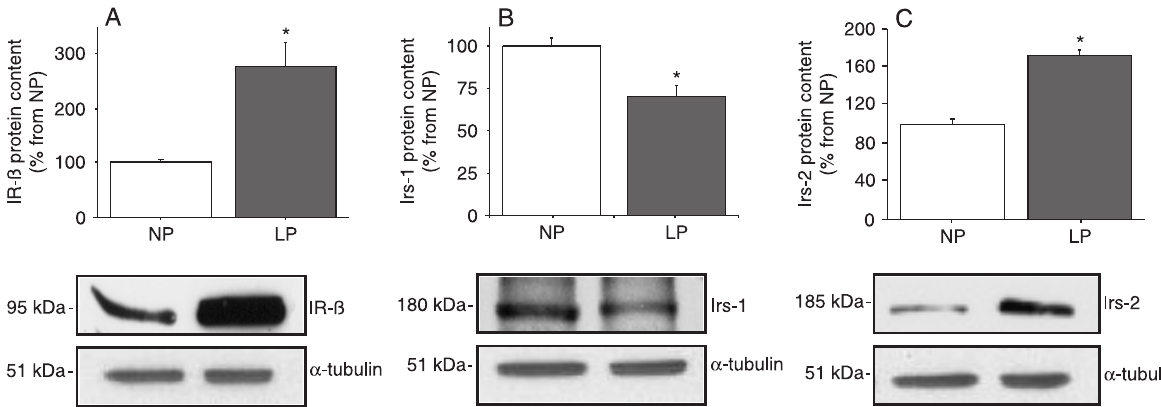
Figure 2. Protein content of A , insulin receptor β (IR-β); B , insulin receptor substrate-1 (Irs-1), and C , insulin receptor substrate-2 (Irs-2) in pancreatic islets from rats receiving a normal-protein diet (NP) and a low-protein diet (LP). A representative control blot for α-tubulin is shown below each panel. Data are reported as means ± SEM for 5 independent experiments. * P < 0.05 compared to NP (Student t- test).